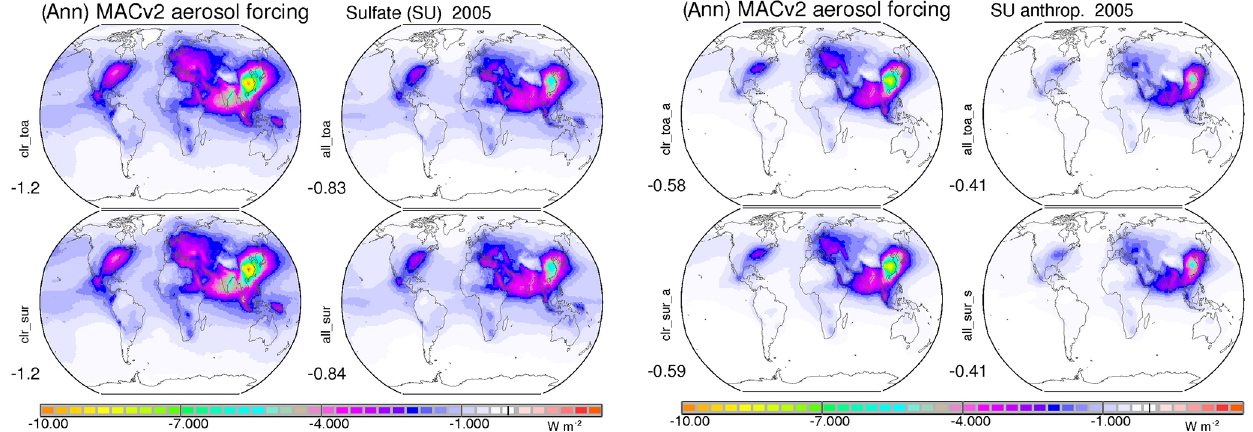
Figure E2. Annual maps for present-day radiative effects of total (left frame) and anthropogenic (right frame) for scattering fine-mode aerosol (SU). Each block displays impacts for clear-sky (left column) and all-sky conditions (right column) at both TOA (top row) and surface (bottom row). Blue to purple, green, yellow and red colors indicate an increasing cooling. Values below the labels are global